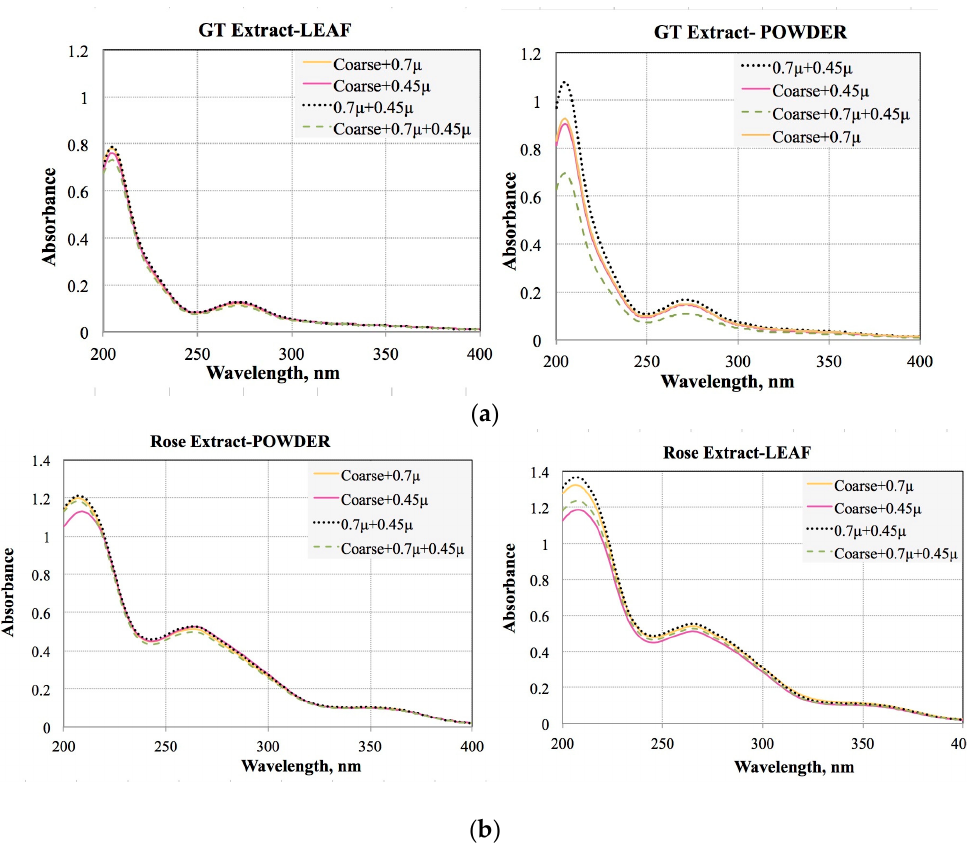
Figure 1. Comparison of the powder and leaf forms for ( a ) Green Tea leaves and ( b ) Rose leaves.